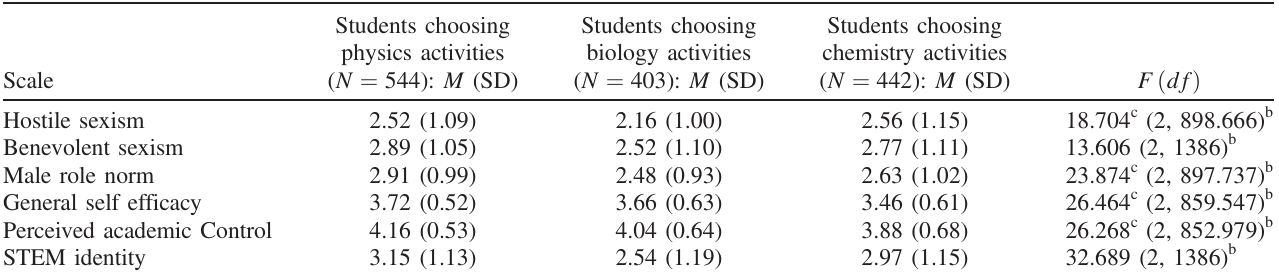
TABLE III. Descriptive statistics with ANOVA test for group differences on the adopted scales.